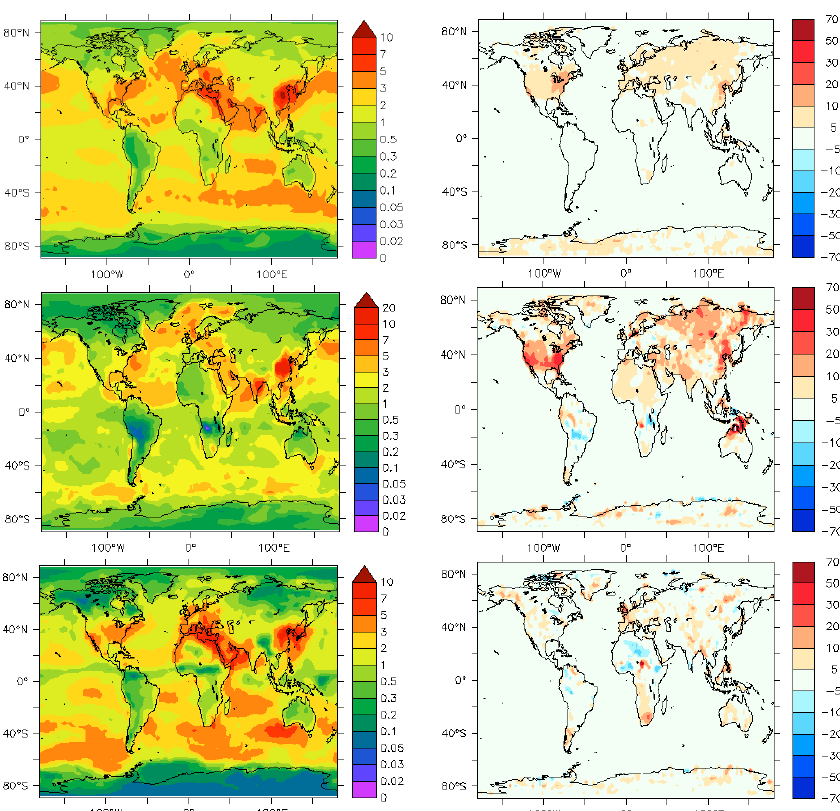
Fig. 3. Simulated aerosol sulphate concentrations (µgm − 3 ) near the surface for the mean annual (upper panels), boreal winter (January, middle panels) and summer (July, lower panels) conditions from the reference run (base_S1) and relative changes (in %, right panels) due to HONO enhancement in the